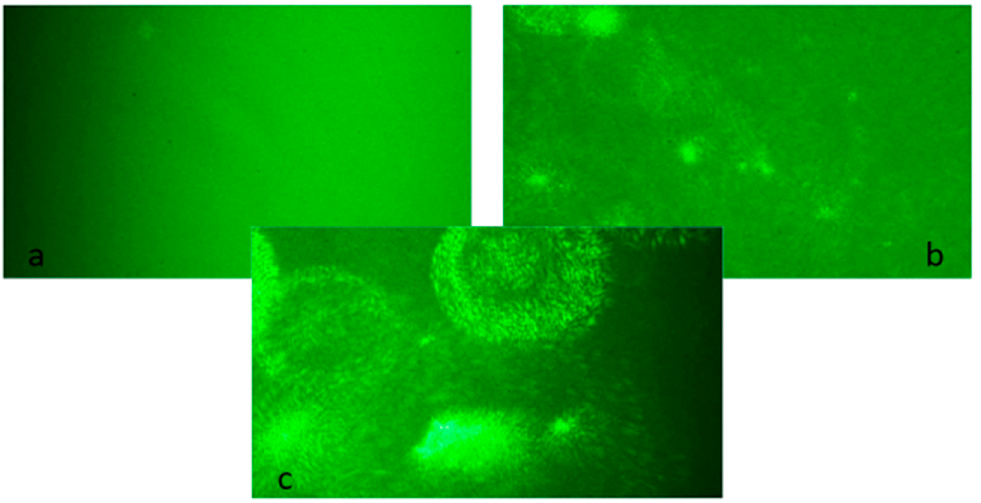
Figure 13. Scattering patterns of monochromatic green semiconductor laser light, passing through: ( a ) citrate-stabilized silver nanoparticles (AgNPs), ( b ) antibody-functionalized silver nanoparticles (AgNPs + ab), and ( c ) nanoparticle aggregates (AgNPs + ab + FLCs).